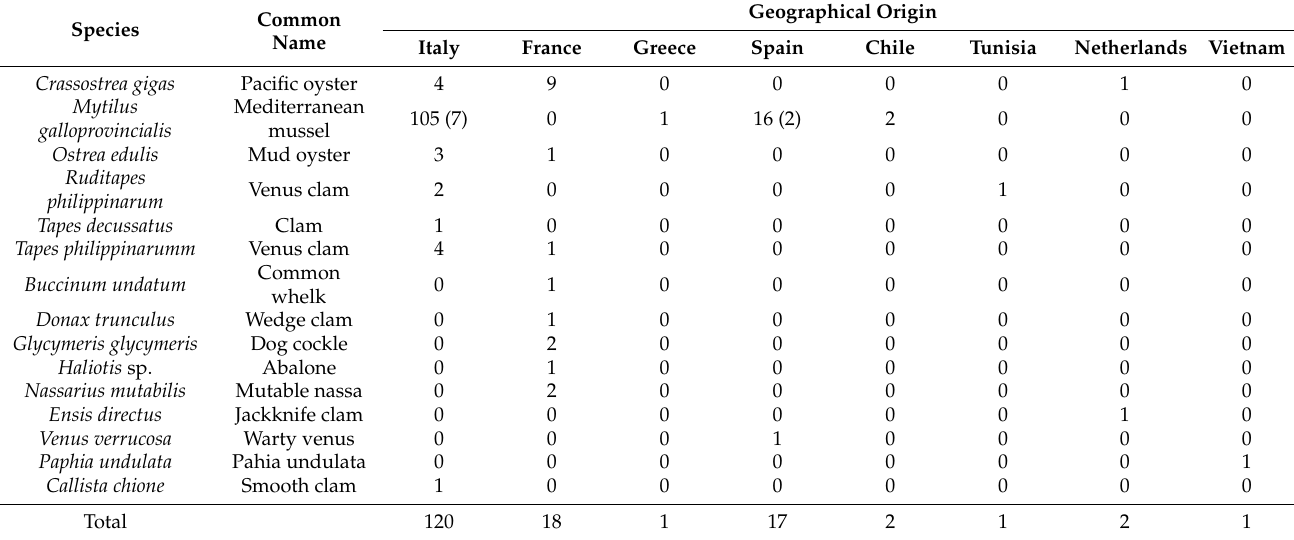
Table 3. Traceability of the viral contamination of shellfish produced and marketed along the food chain in Sicily, Italy, from April 2017 to September 2019. Positive samples are indicated in parenthesis and extended data presented in Table 4.